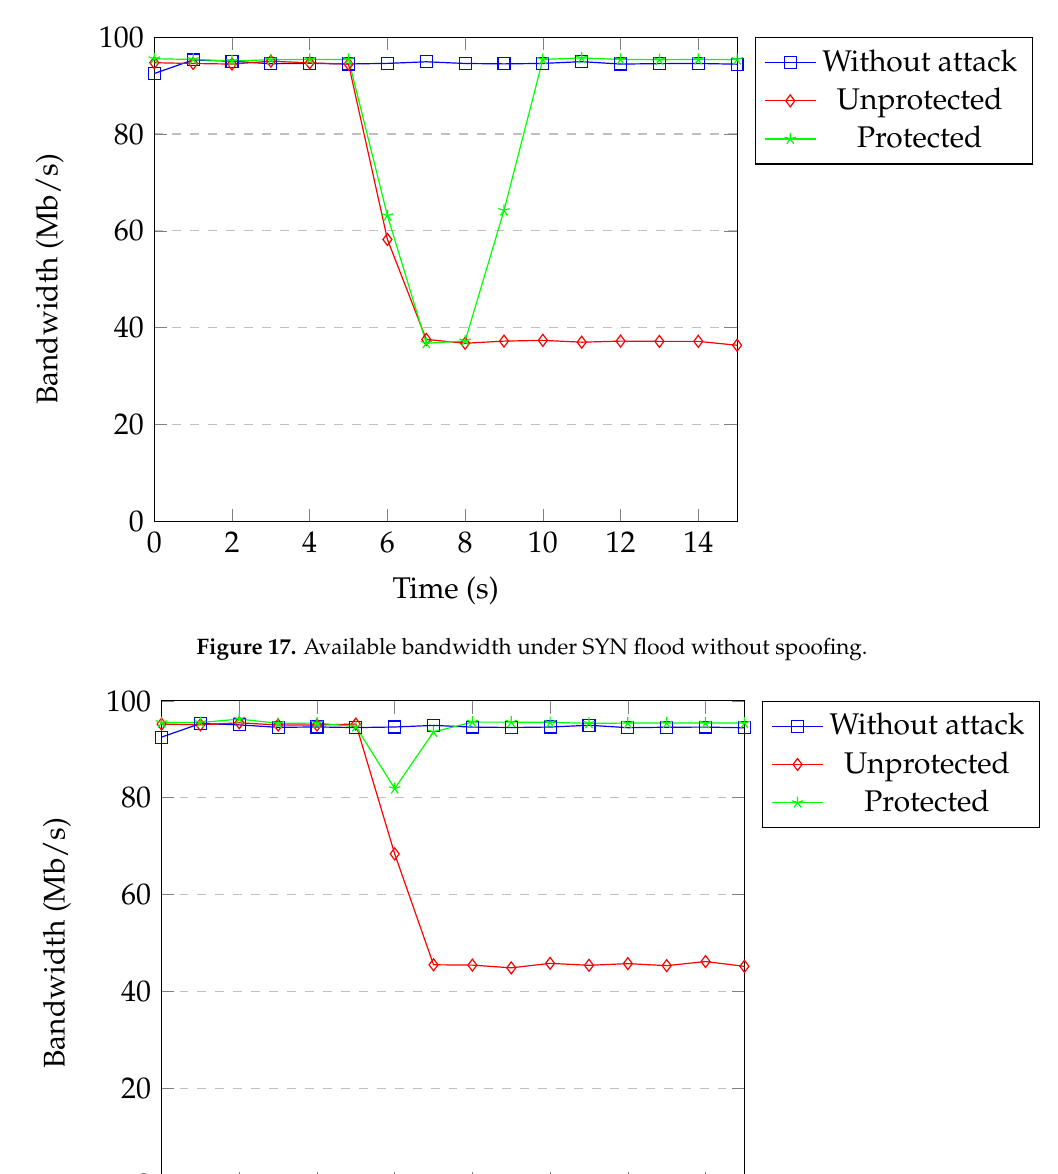
Figure 19. Available bandwidth under UDP flood without spoofing.